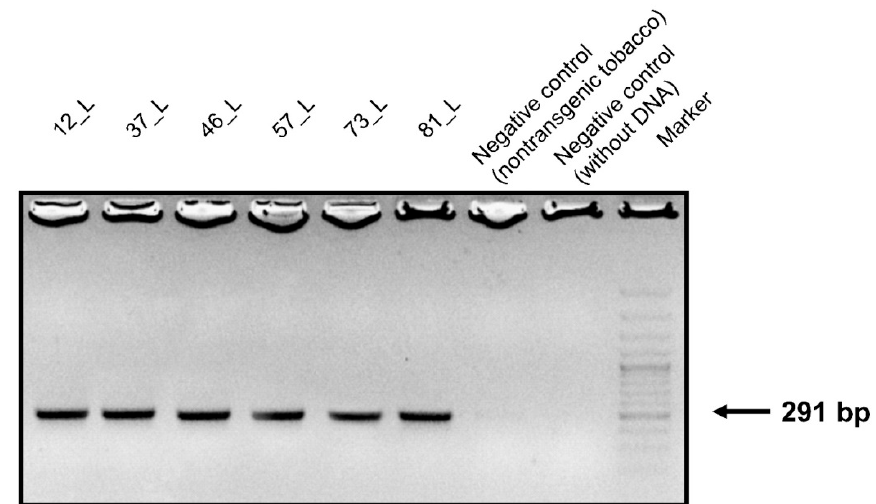
Figure 2. Agarose gel electrophoresis of the PCR products. Amplified DNA fragments of 291 bp from the leaves of transgenic tobacco fractionated on a 1.3% agarose gel. Size marker: GeneRuler™ 50 bp DNA ladder.